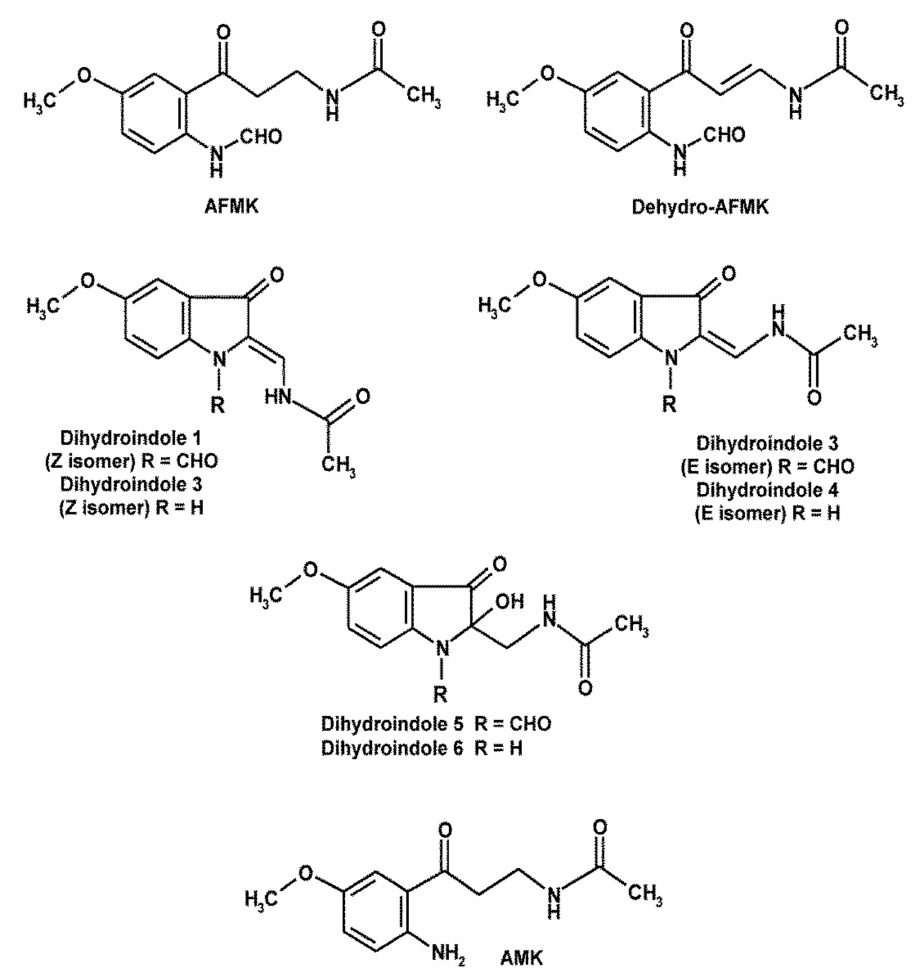
Figure 2. Melatonin-derived kynuramines and several secondary products with indolinone-like structures formed by inter- action of AFMK with free radicals. Abbreviations: AFMK, N 1 -acetyl- N 2 -formyl-5-methoxykynuramine; AMK, N 1 -acetyl-5- methoxykynuramine; dihydroindoles 1, 2, N -(1-formyl-5-methoxy-3-oxo-2,3-dihydro-1H-indol-2-ylidenemethyl)-acetamide, Z and E isomers, respectively; dihydroindoles 3, 4, deformylated analogs of dihydroindoles 1 and 2; dihydroindole 5, N -(1-formyl-2-hydroxy-5-methoxy-3-oxo-2,3-dihydro-1H-indol-2-ylmethyl)-acet- amide; dihydroindole 6, deformylated analog of dihydroindole 5. Deformylated metabolites carry a nitrosylatable